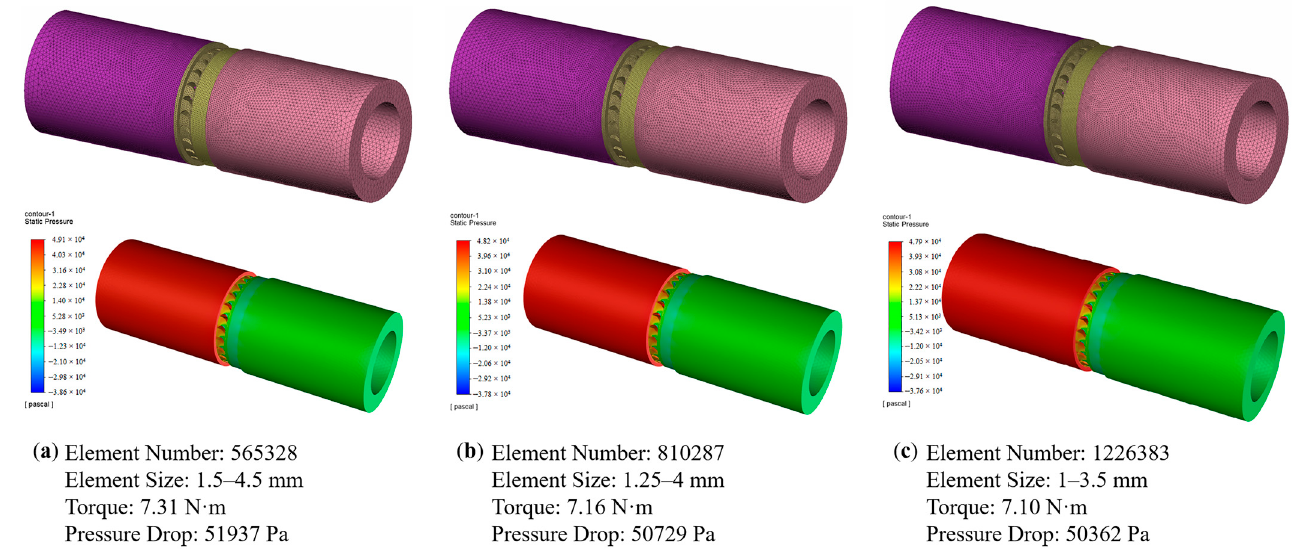
Figure 3. A typical grid independence test procedure: ( a ) the third-to-last result; ( b ) the second-to-last result; ( c ) the last